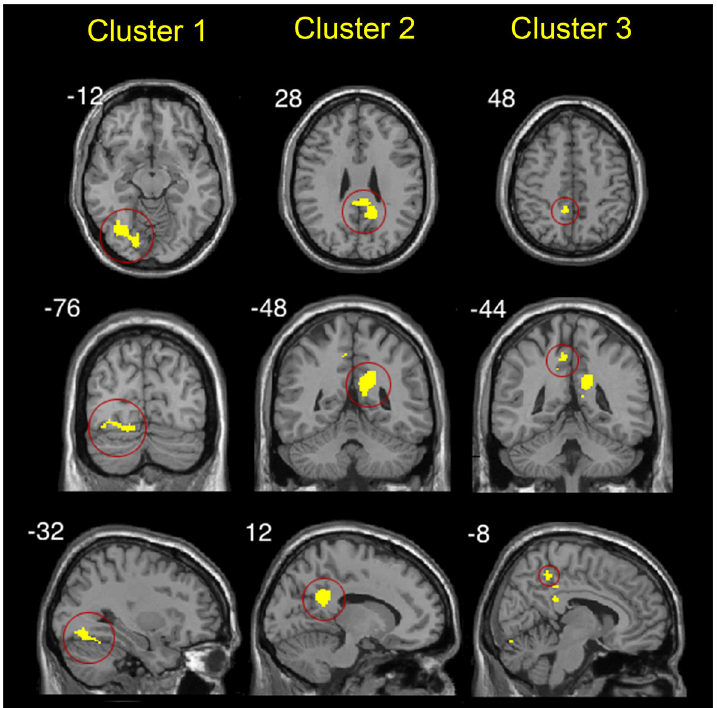
Figure 3. The common regions (three clusters) negatively correlating with finger gnosis, for addition and subtraction. The number next to each transverse, coronal, and sagittal image indicates respective slice numbers from which the images where